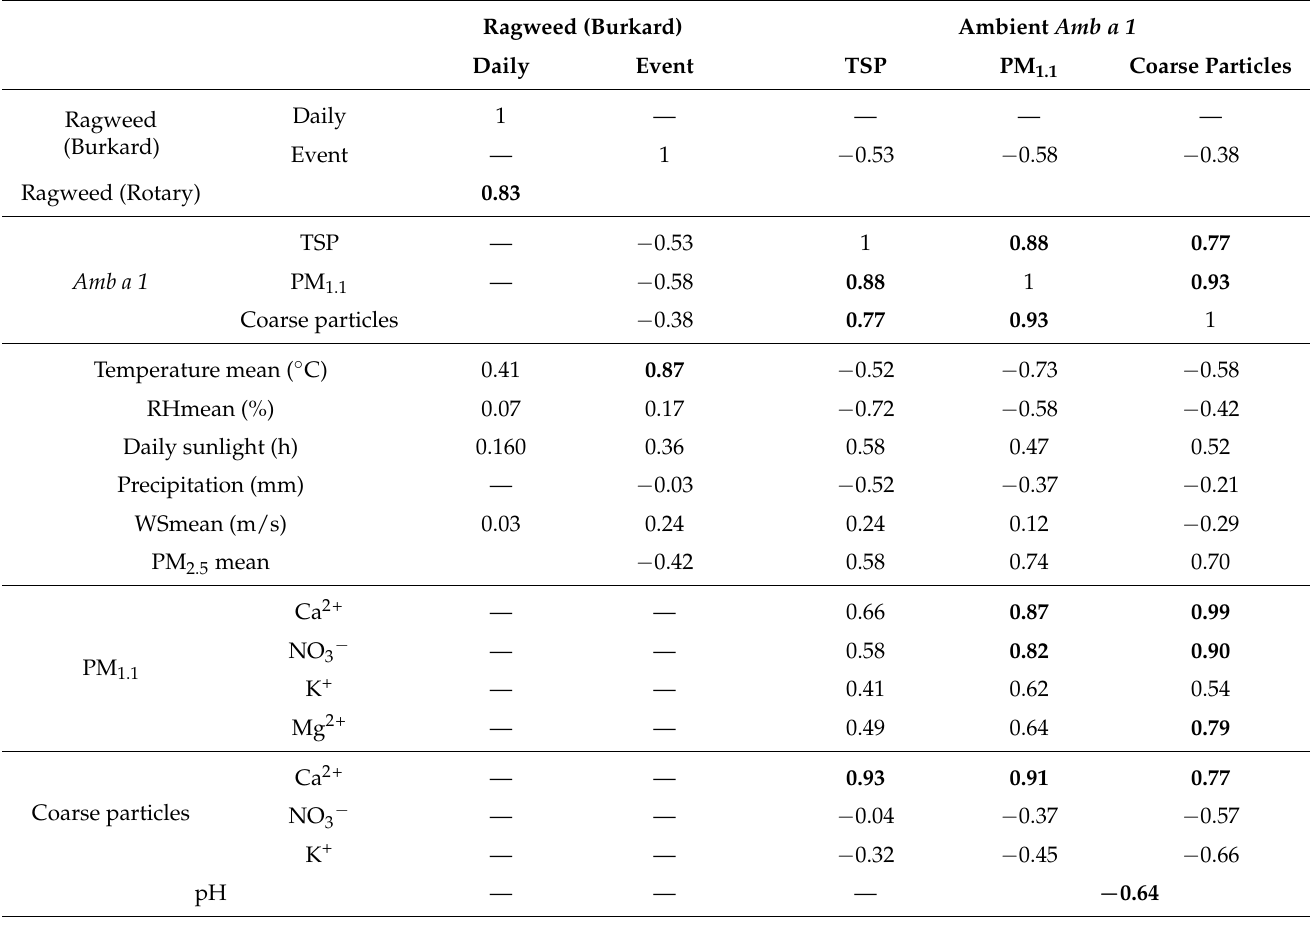
Table 1. Results of Pearson correlation coefficient between ragweed pollen, Amb a 1 , and meteorologi- cal parameters and air